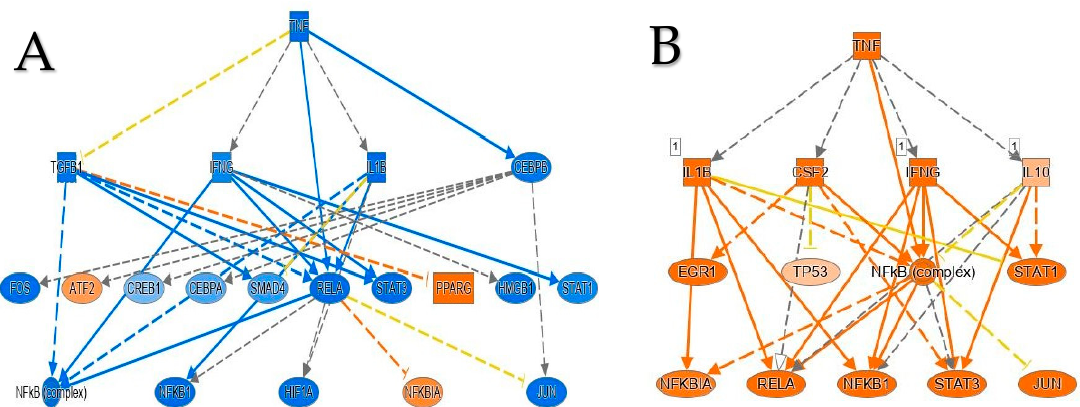
Figure 6. Regulator affects network analysis based on IPA highlighting a role for activated TNF- affected signaling networks comparison. ( A ) This figure is representation of TNF downregulated network according to IPA prediction in obese individuals with IR-NGT. ( B ) TNF is enriched as an upstream regulator network in obese individuals with T2D compared to lean individuals based on IPA analysis.